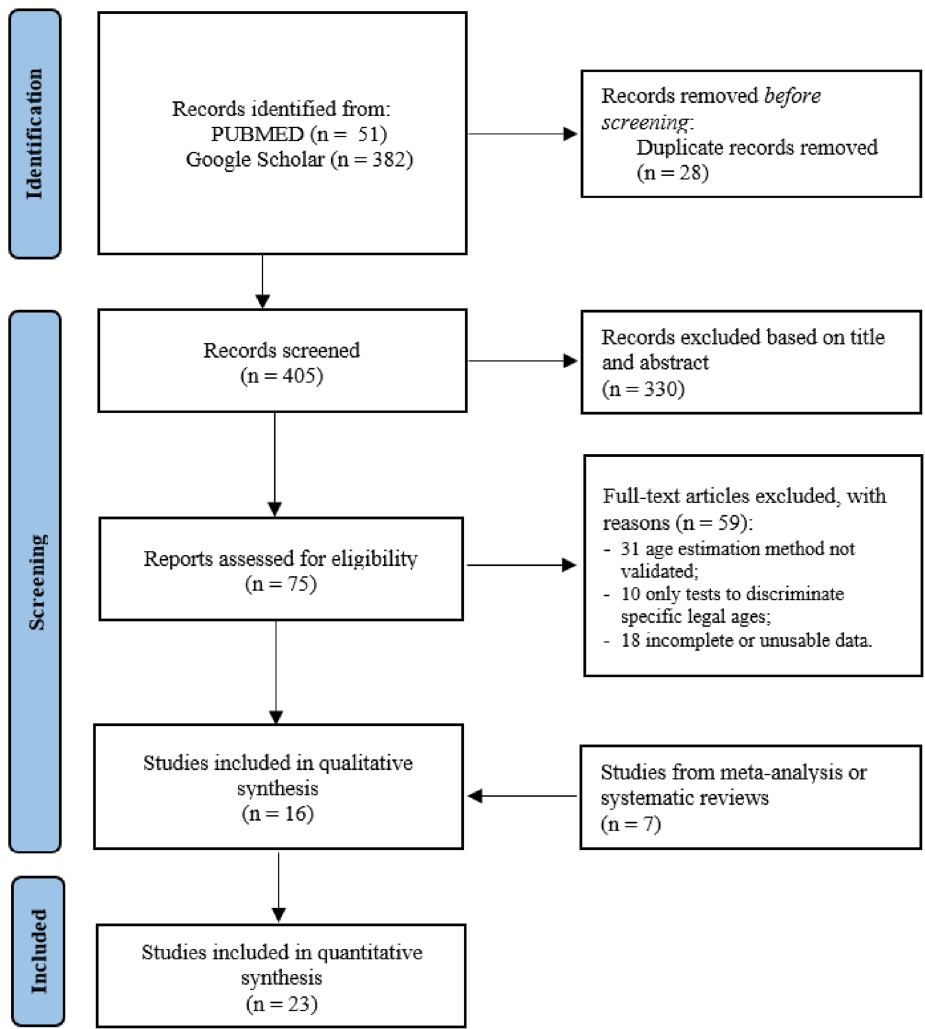
Figure 1. PRISMA flow diagram of the search results from the